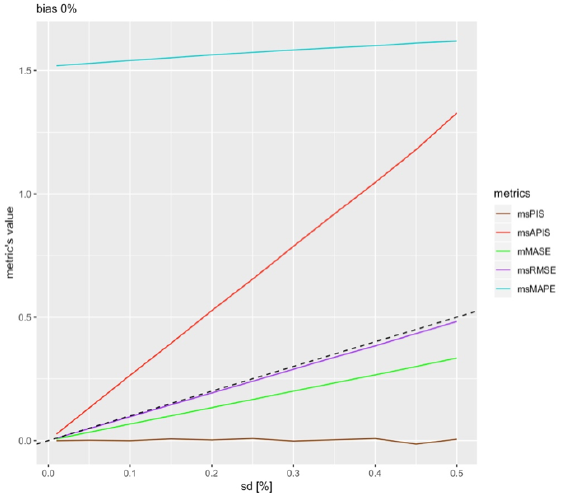
Figure 3. Standard deviation sensitivity of scaled performance metrics in absence of bias.